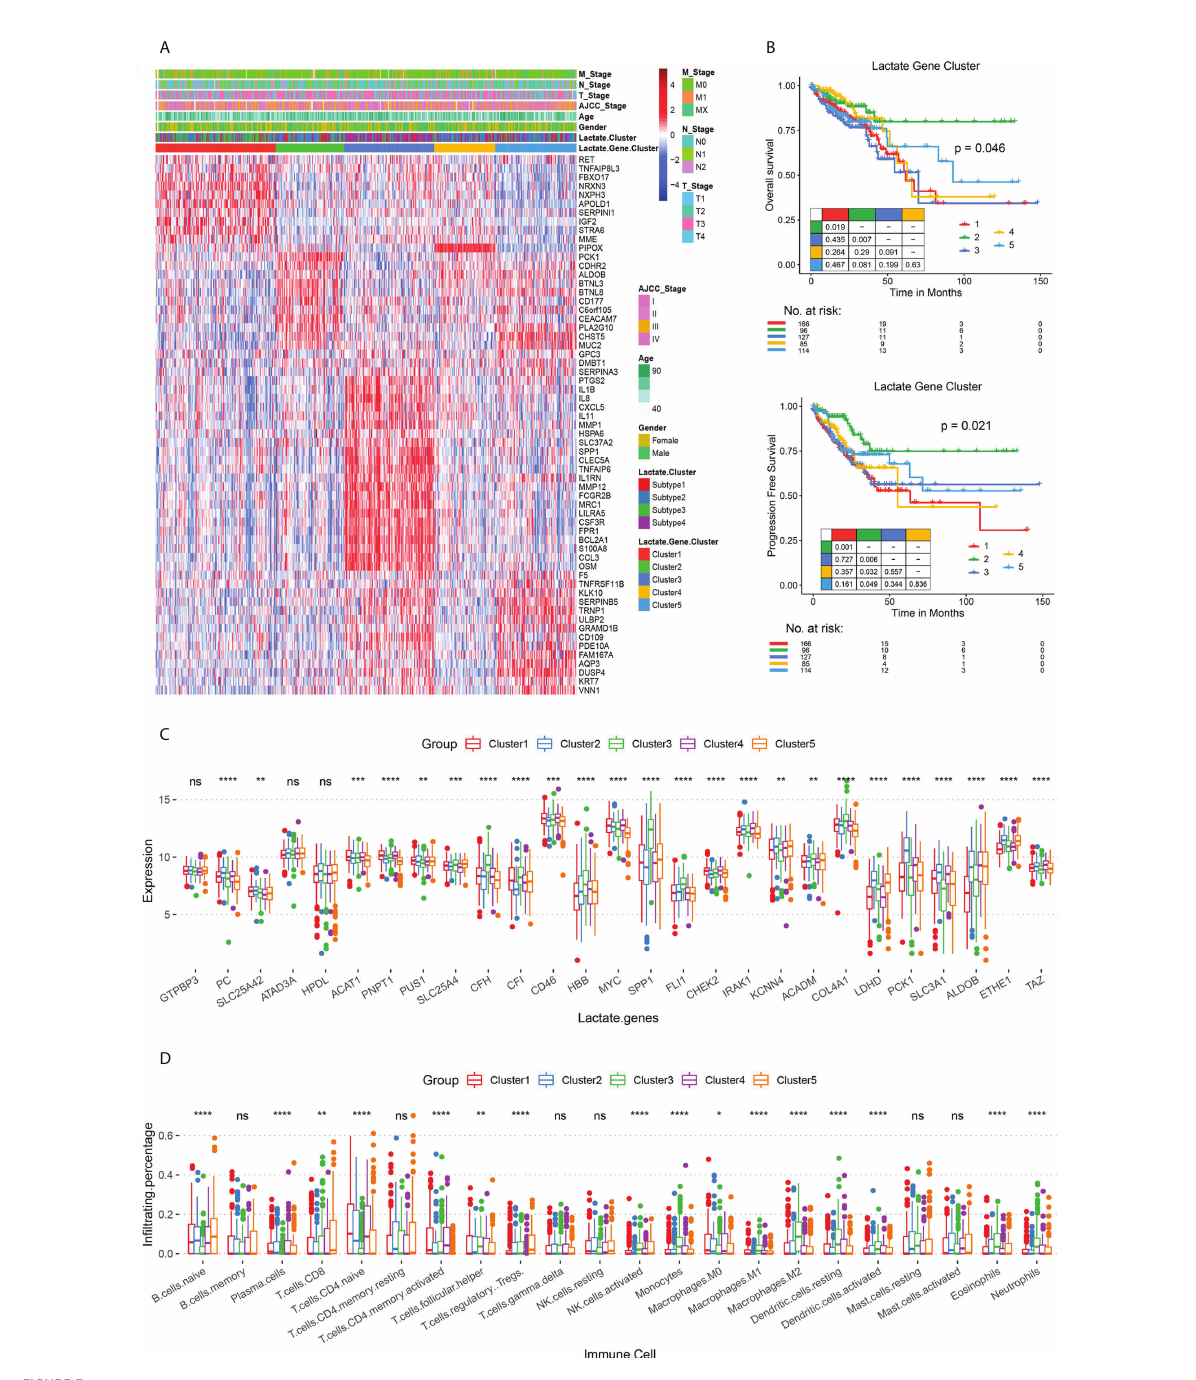
FIGURE 3 Lactate phenotype-related subtypes and differences in their survival rates and immune cell in fi ltration. (A) Heat map of lactate phenotype- related genes in fi ve subtypes (clusters 1 - 5), along with age, sex, AJCC tumor stage, and TNM stage. The lactate-related subtypes are also labeled. (B) The OS and PFS analysis among subtypes; P values derived from a log-rank test. Pairwise comparison is also displayed. (C) Box plot for comparing the expressions of lactate-related genes among clusters 1 - 5. (D) Box plot for comparing the in fi ltration percentage of 22 immune cells; immune cell in fi ltration has been evaluated by CIBERSORT. In (C, D) , * P < 0.05; ** P < 0.01; *** P < 0.001; **** P < 0.0001; ns, not signi fi cant (Kruskal-Wallis